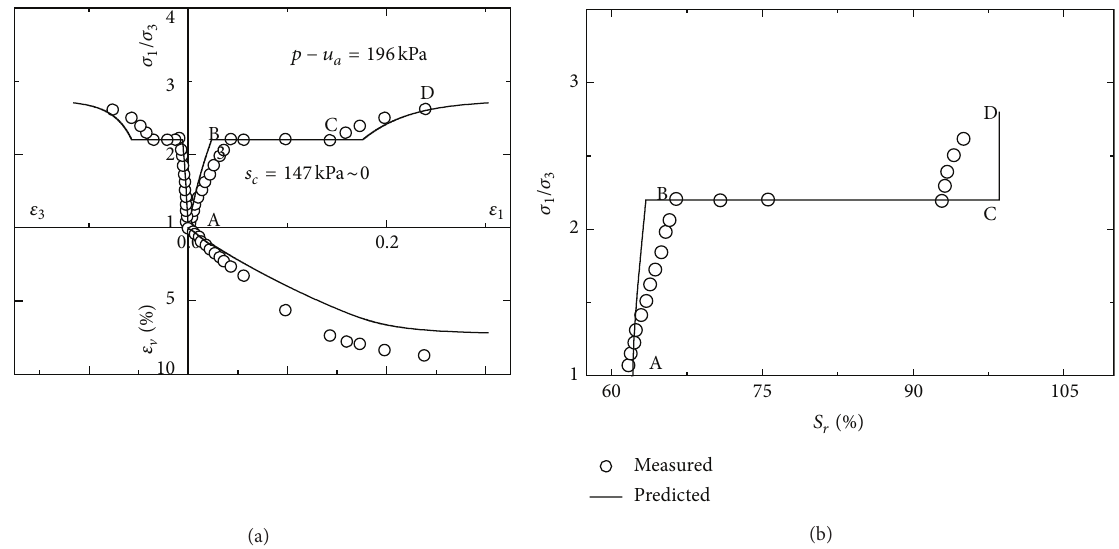
Figure 10: Simulated and measured results of triaxial tests with stress Path A-B-C-D (data after Sun et al. (2007) [2]).